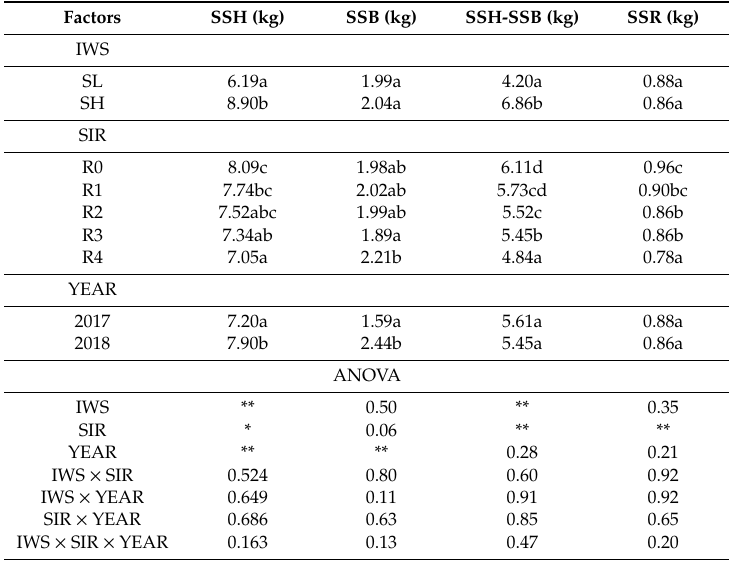
Table 5. Main effects of straw incorporation rate (SIR), irrigation water salinity (IWS), and growing season (YEAR) on salt balance within the 0–100 cm soil profile, and results of the three-way ANOVA with irrigation water salinity (IWS), straw incorporation rates (SIR), and growing season (YEAR) as